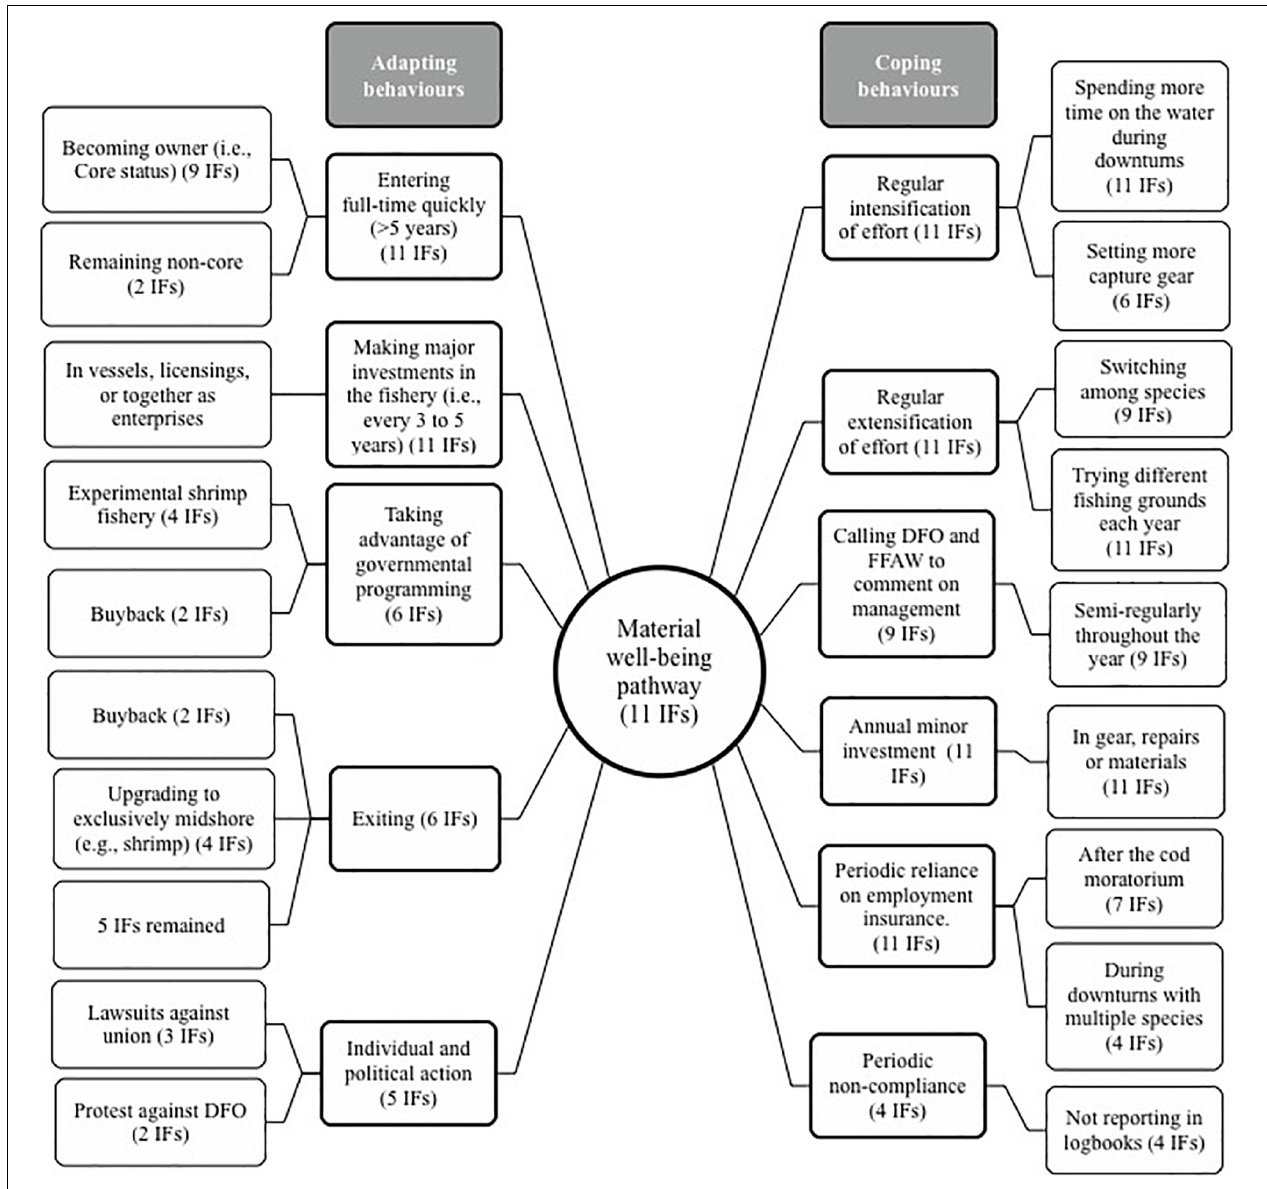
FIGURE 4 | The material well-being pathway